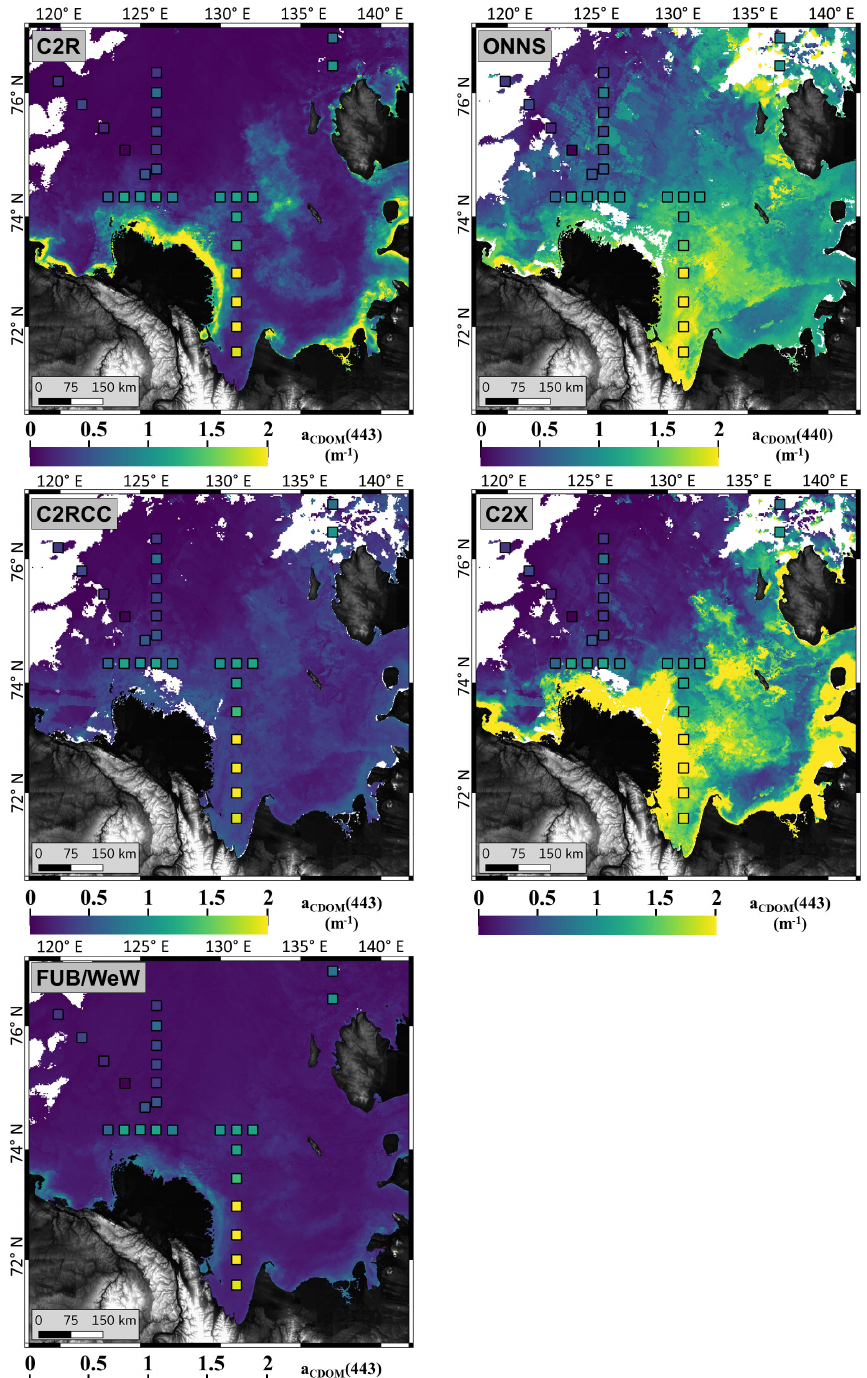
Figure 6. Surface water a CDOM (λ) sat from MERIS mosaic from five scenes from September 2010 (scenes listed in Table 2) for all tested OCRS algorithms (C2R, ONNS, C2RCC, C2X, FUB/WeW). Squares show in situ a CDOM (443) ( a CDOM (440) for ONNS) with colours according to the same colour scale as satellite